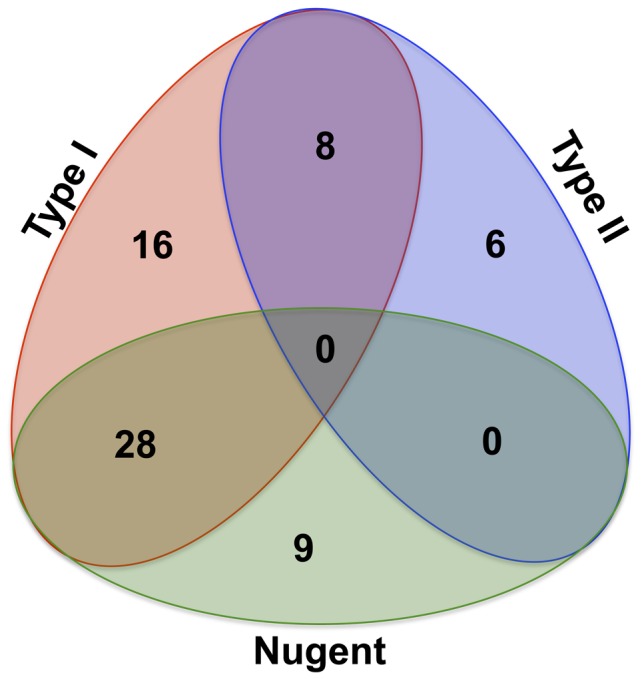
Venn Diagram of Discriminative Metabolites.Shown is a Venn diagram of the numbers of unique and shared metabolites that delineate high Nugent scoring (≥7), Type I symptomatic BV or Type II symptomatic BV from other samples.